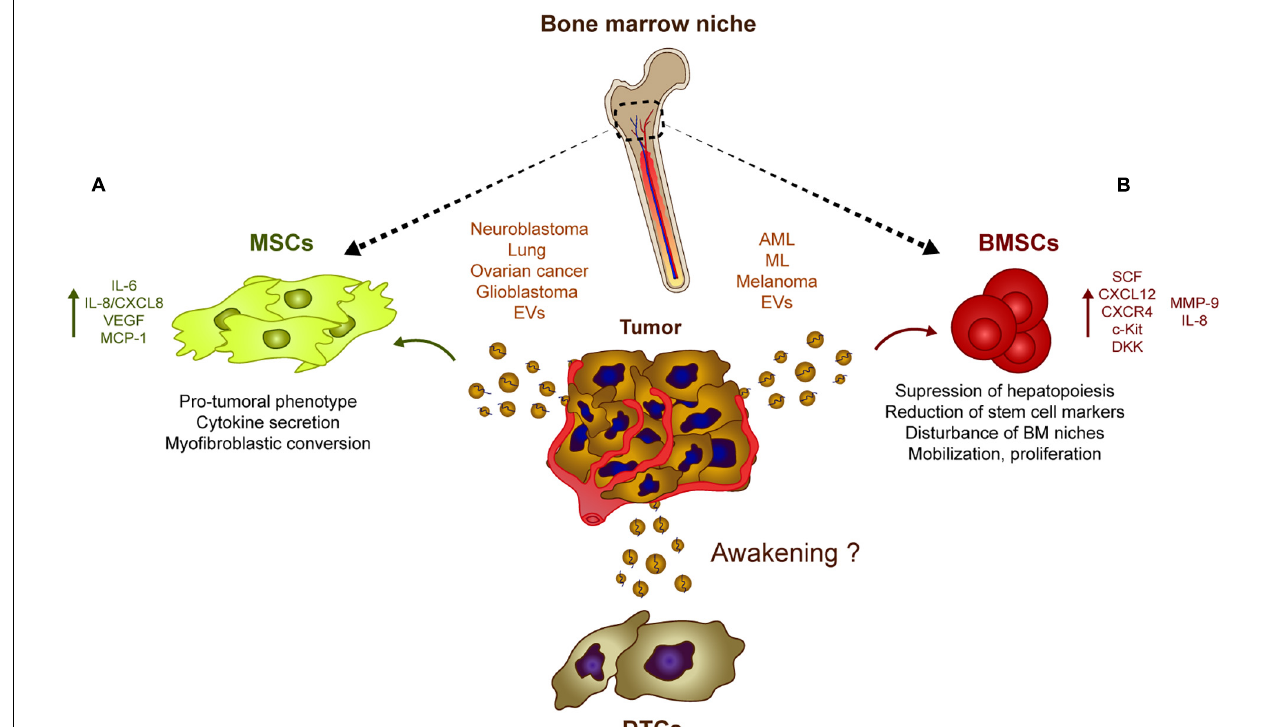
FIGURE 2 | Tumor-derived EVs influence stromal populations. Rather than inducing DTC dormancy, tumor-derived EVs could contribute to their re-awakening through different mechanisms. (A) Neuroblastoma, glioblastoma, lung, and ovarian cancer generate EVs capable of inducing a pro-tumoral phenotype in MSCs which usually involves a myofibroblastic conversion. These modified MSCs eventually upregulate the secretion of pro-tumoral cytokines and chemokines such as IL-8, IL6, and VEGF. (B) Similarly, melanoma or leukemia cells release EVs that are captured by BMSCs which induces the secretion of IL8, CXCL12 among other soluble factors. This tumor EV-mediated release of cytokines and chemokines has an effect on the bone marrow physiology suppressing hematopoiesis and disturbing several features of the bone marrow progenitors, which favor the growth of tumor cells at dormant niches.